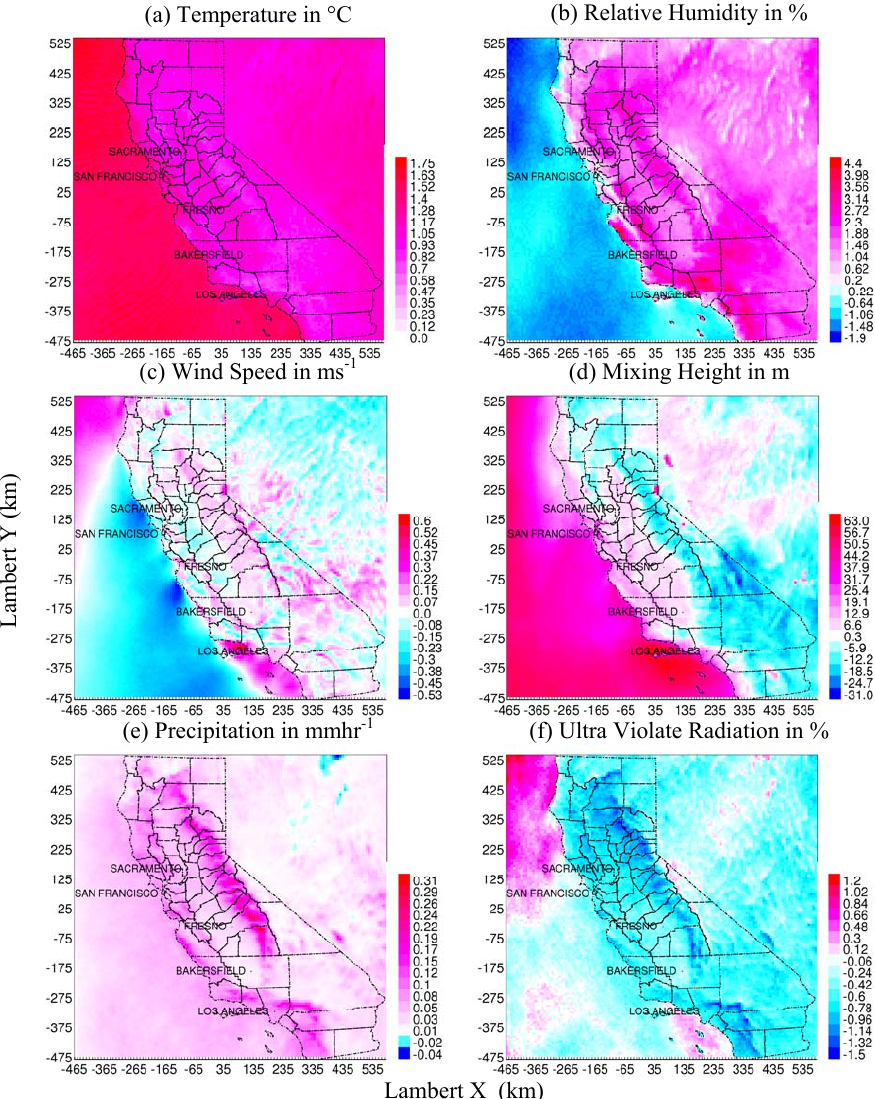
Fig. 2: Panels (a)-(f) show changes in annual average values in meteorological parameters likely to occur due to climate change in the future (2047-53) from the present- day